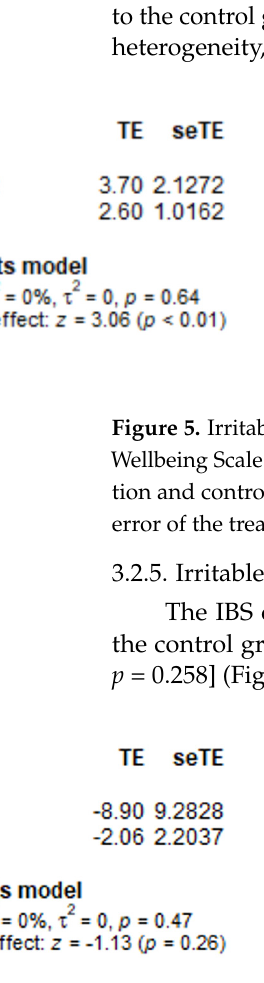
Figure 4. Irritable bowel syndrome—perceived stress standardized mean difference comparison between mindfulness intervention and control. IBS-PS, irritable bowel syndrome perceived stress; SMD, standardized mean difference; TE, treatment effect as SMD; seTE, standard error of the treatment effect; CI, confidence interval [15,17,21].